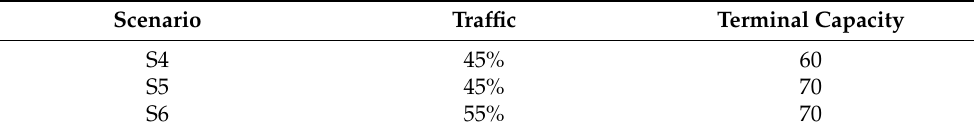
Table 4. Additional scenarios based on the increase of the terminal